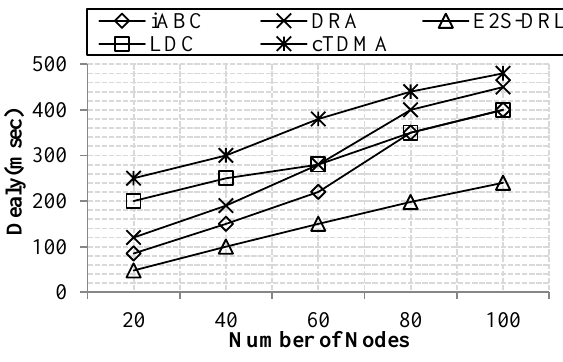
Figure 9. Comparison of delay.